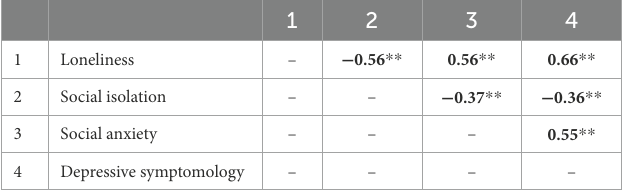
TABLE 3 Correlational matrix for predictor variables and